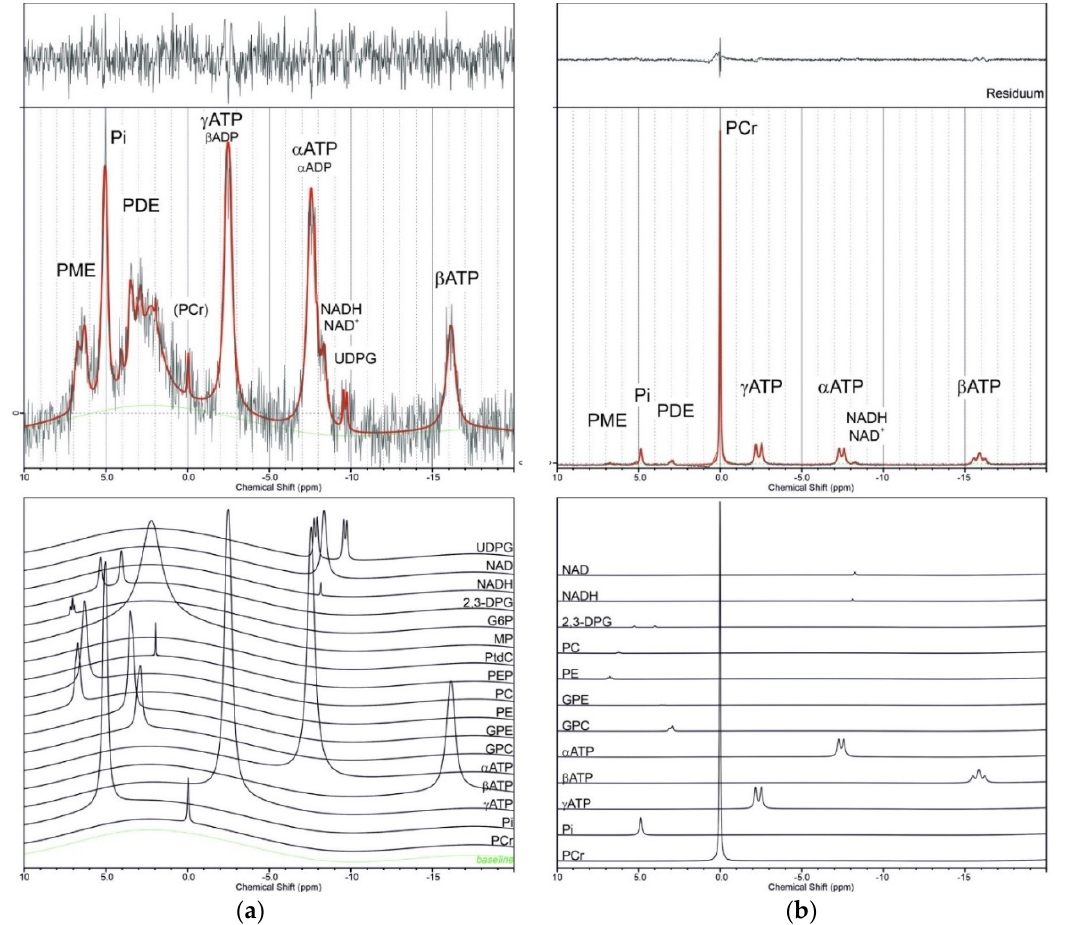
Figure 1. Examples of in vivo 31 P spectra of the liver ( a ) and calf muscles ( b ). Black lines represent measured spectra, red lines show spectra calculated by LCModel with the application of the BASIS p data set, and the green line represents the calculated baseline. In the upper panels of the picture, individual contributions of metabolites to the calculated spectra are shown: UDPG—uridine-diphosphoglucose; NADH/NAD + —nicotinamide adenine dinucleotide; 2,3-DPG—2,3 diphosphoglycerate; G6P—glucose-6-phosphate; G1P—glucose-1-phosphate; MP—membrane phospholipids; PEP—phosphoenolpyruvate; PC—phosphocholine; PE—phosphoethanolamine; GPE—glycerophosphoethanolamine; GPC—glycerophosphocholine; PtdC—phosphatidylcholine (overlapped with PEP); ATP—adenosine triphosphate; ADP—adenosine diphosphate; Pi—inorganic phosphate; PCr—phosphocreatine (in the case of the liver spectrum, this signal is the contamination; it can serve as the standard for chemical shift measurement); PME—phosphomonoesters region; PDE—phosphodiesters region. (In vivo spectra of the liver and calf muscles of a young, healthy volunteer were taken from the database of the MR group IKEM. The liver spectrum was measured at 3 T TRIO MR system, 1 D ISIS, TR = 2 s, acq = 196, TE = 0.2 ms, bandwidth 3000 Hz; muscle spectrum was obtained at VIDA 3 T MR system, FID sequence, TR = 15 s, bandwidth 2000 Hz; unpublished results.